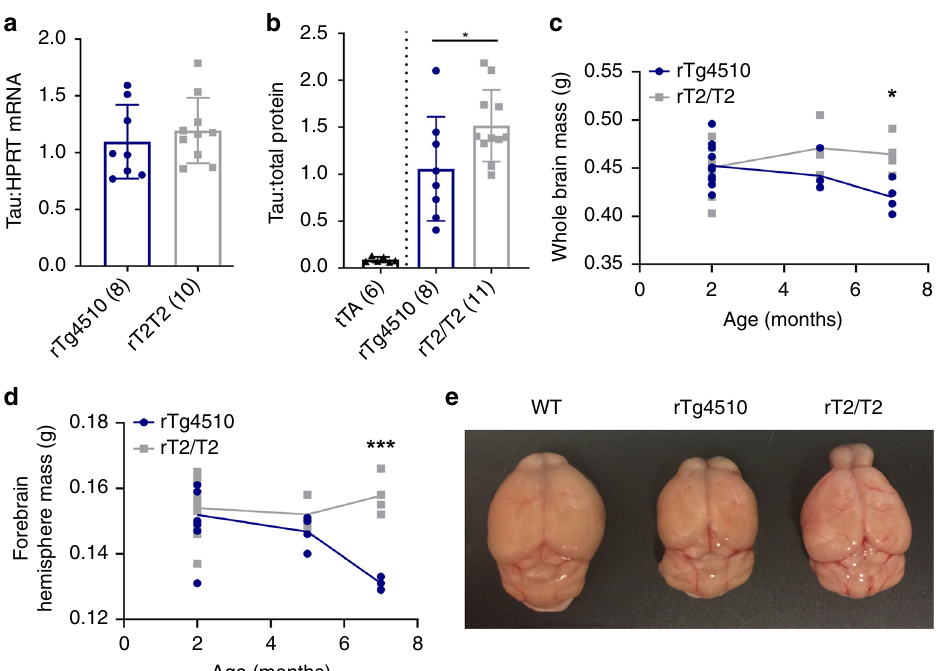
Fig. 1 No premature gross forebrain atrophy in rT2/T2 despite greater overexpression of tau P301L . a We used relative qRT-PCR on RNA extracted from mouse forebrain-hemispheres to determine tau expression levels relative to Hprt ( n ’ s in parentheses). Samples were run in triplicate and the experiment was replicated twice. All data are normalized to a positive calibrator run with each plate to control for inter-plate variability within experiments. An unpaired two-tailed t test was conducted ( p = 0.501, t = 0.6882, d f = 16, 95% CI [ − 0.21 to 0.41]). b Protein from mouse forebrains was treated with phosphatase and analyzed by semiquantitative western blot relative to total protein loaded ( n ’ s in parentheses). A pan-tau antibody (Tau46) was used to quantify fold-overexpression of human tau relative to endogenous tau in tTA mice, and was found to be 17-fold in rT2/T2 and 12-fold in rTg4510. An unpaired two-tailed t test revealed higher overexpression in rT2/T2 than rTg4510 ( p = 0.046, t = 2.16, d f = 17, 95% CI [0.010 – 0.91]). The full blots are shown in Supplementary Fig. 13. c Whole brains were dissected from 2-month (rTg4510 n = 10, SD = 0.022; rT2/T2 n = 11, SD = 0.023), 5-month (rTg4510 n = 4, SD = 0.020; rT2/T2 n = 3, SD = 0.032), and 7-month-old mice (rTg4510 n = 4, SD = 0.017; rT2/T2 n = 4, SD = 0.020) and